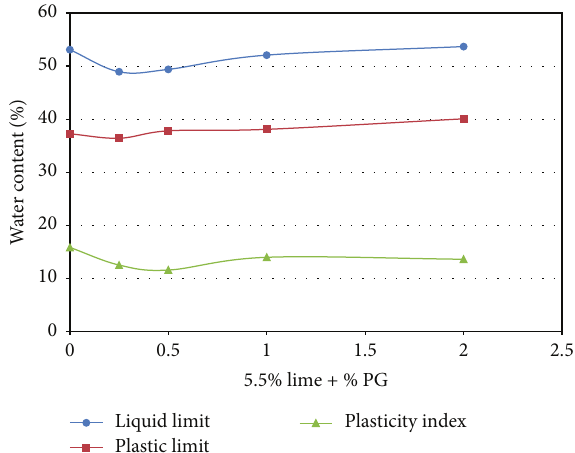
Figure 6: Comparison of plasticity of lime stabilized soil admixed with PG.